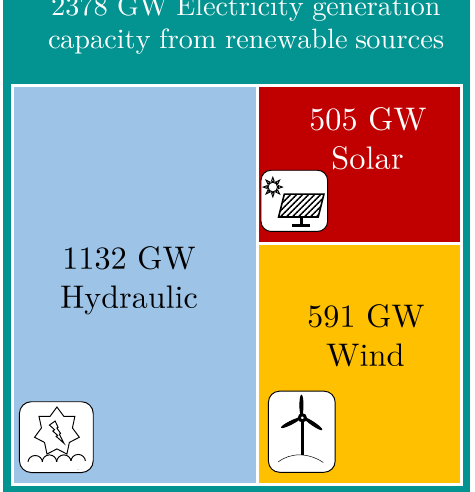
Figure 1. Electricity generation capacity scheme from renewable energy sources.